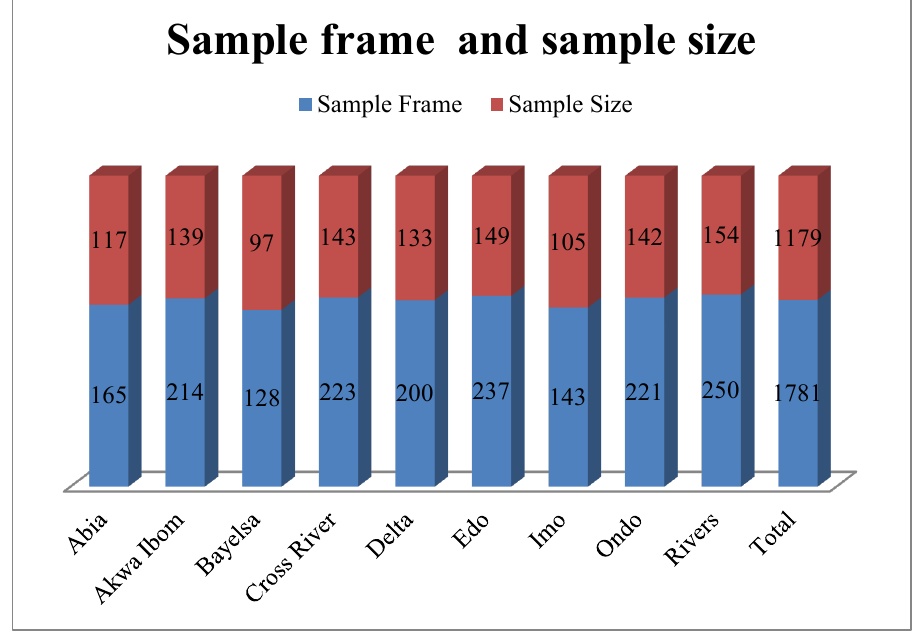
Fig. 1. Sample frame and sample size (developed by the